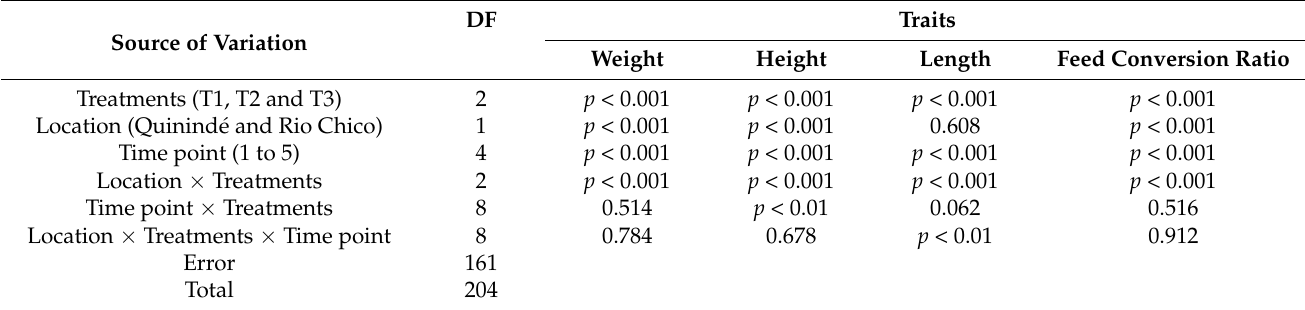
Table 3. Repeated measures analysis for the productive performance parameters.